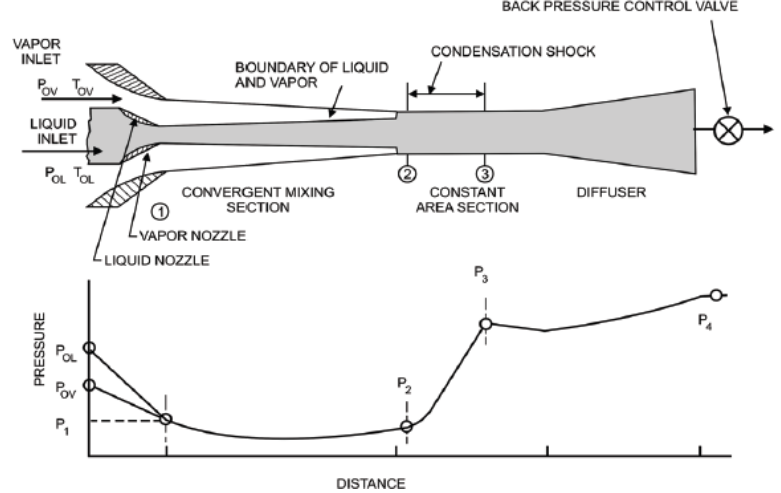
Figure 10. Condensing ejector scheme and pressure distribution [83]. Table 21. Operating parameters from Bergander et al. [83].